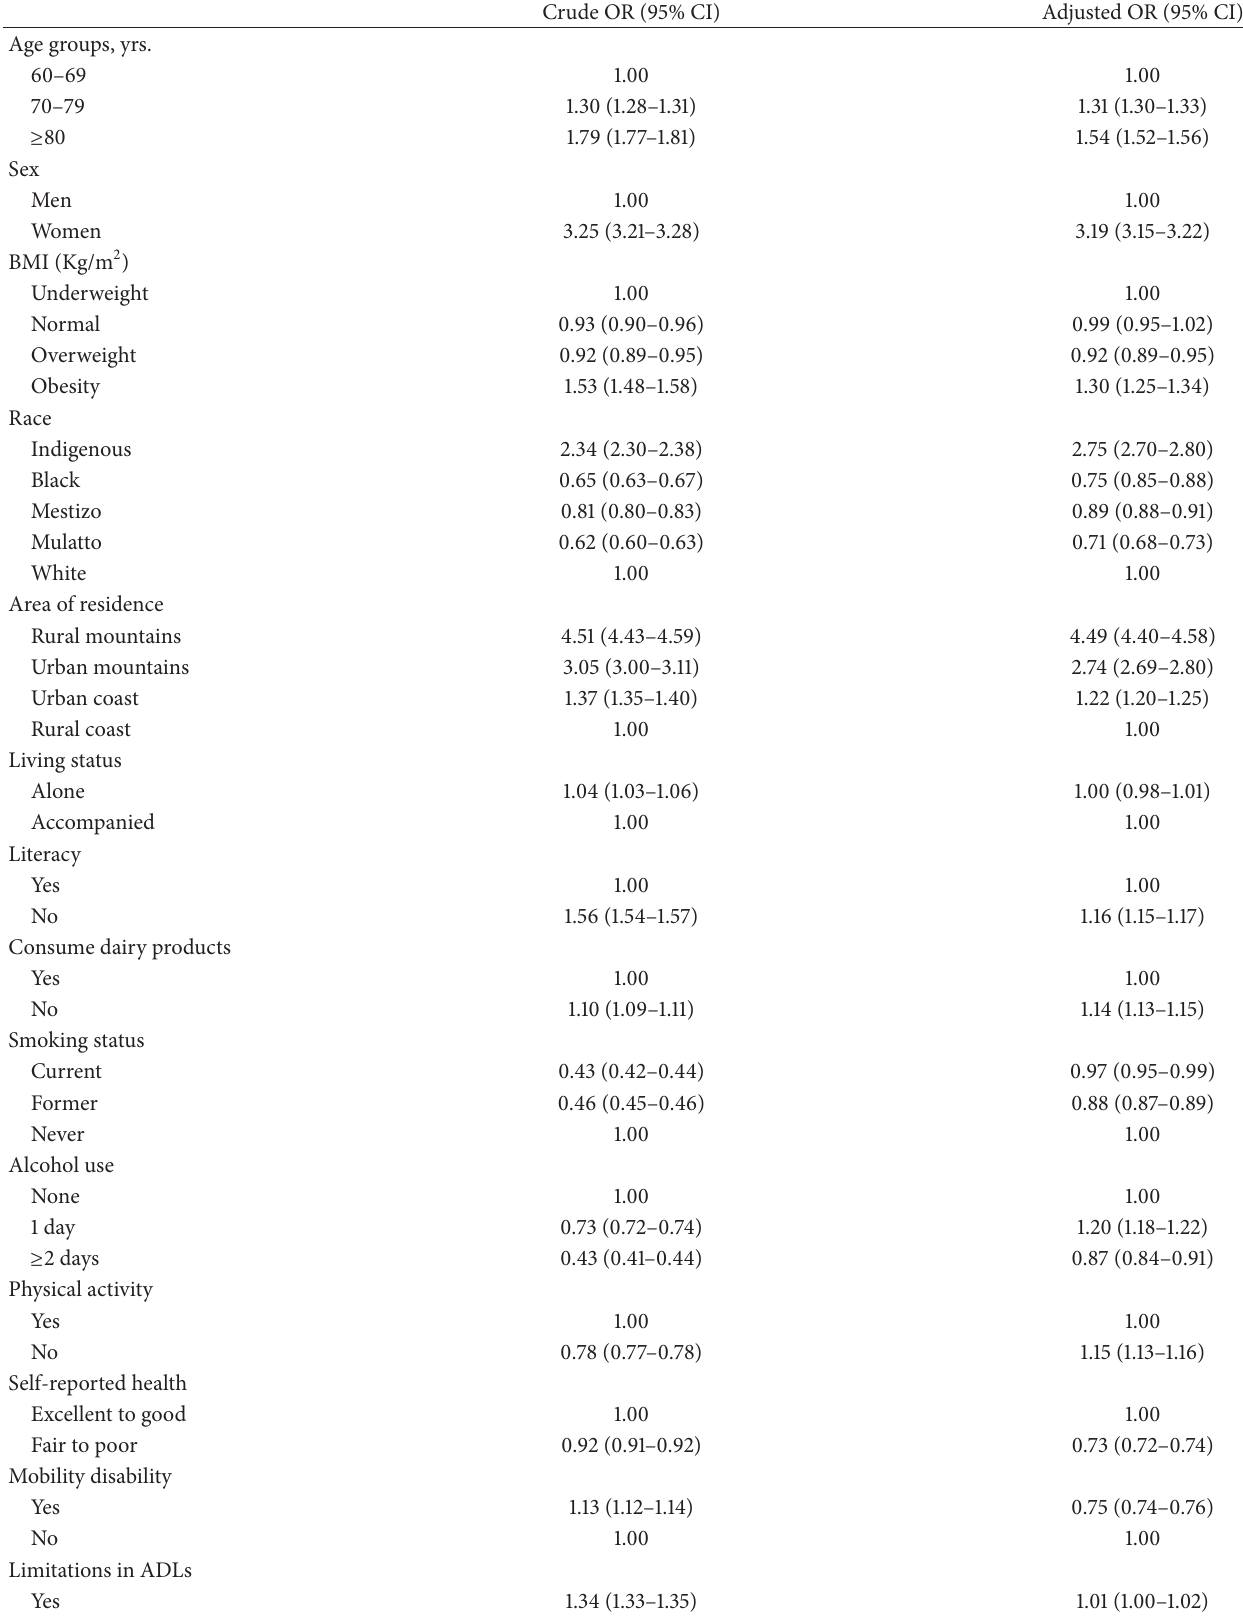
Table 3: Associations between characteristics of participants and 25(OH)D